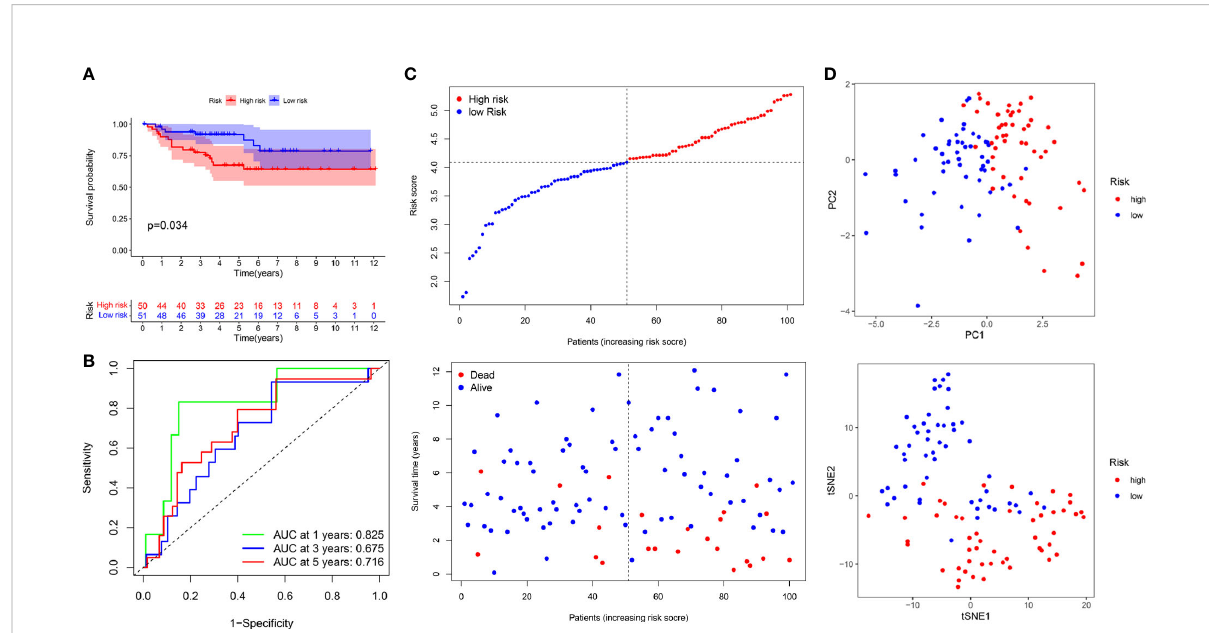
FIGURE 9 The prognostic value of PRIs prognostic for KIRC patients in an independent E-MTAB-1980 validation cohort. (A) Kaplan-Meier analysis of KIRC patients strati fi ed by the median risk score in the E-MTAB-1980 cohort. (B) The time-dependent ROC curve for OS in the E-MTAB-1980 cohort. (C) The distribution of the risk score and OS status in the E-MTAB-1980 cohort. (D) PCA and t-SNE analyses in the E-MTAB-1980